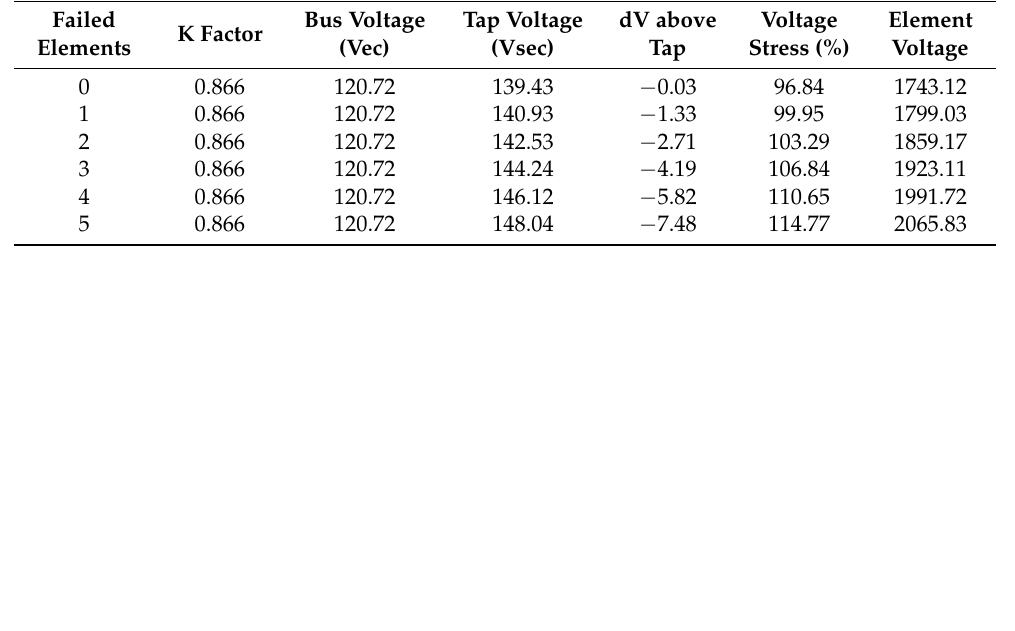
Table 2. Failures of the above tap elements are all part of the same string. Voltage Differential Protection Settings Table (Same String above